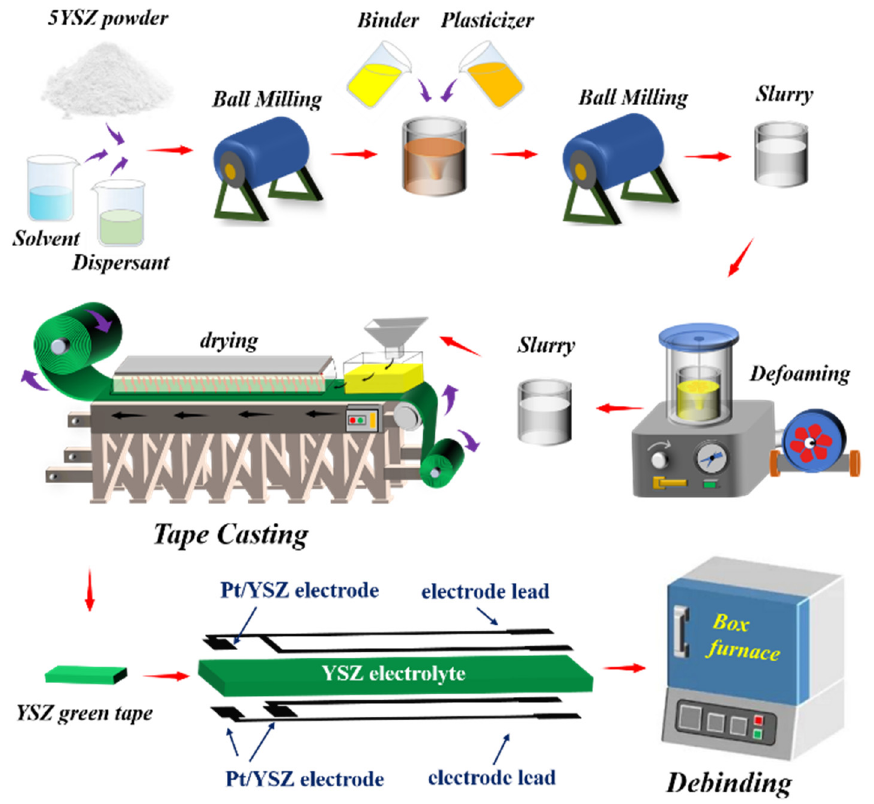
Figure 2. Sample preparation process of the (Pt/YSZ)/YSZ sensor unit.